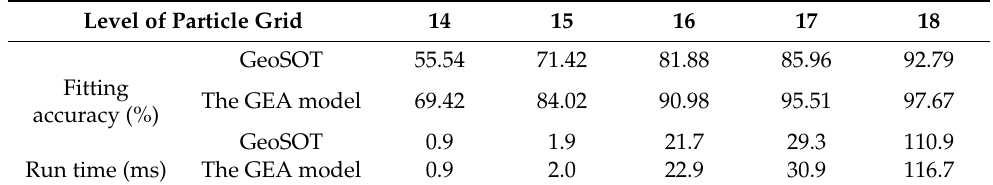
Table 1. Accuracy and efficiency of particle grids at different levels for GeoSOT and the GEA model. Level of Particle Grid